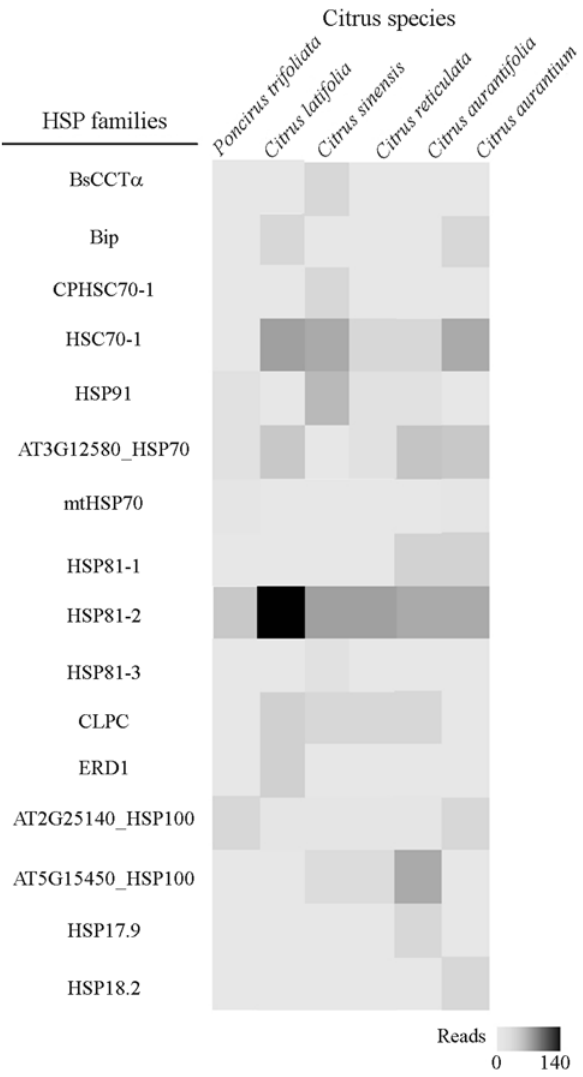
Figure 4 - Expression profile of heat shock proteins-like transcripts in healthyleavesfrom Citrusaurantifolia , Citrusaurantium , Citruslatifolia , Citrus sinensis , Citrus reticulata and Poncirus trifoliata . Data represents the normalized relative number of reads from a specific library showing sequence similarity to the ion